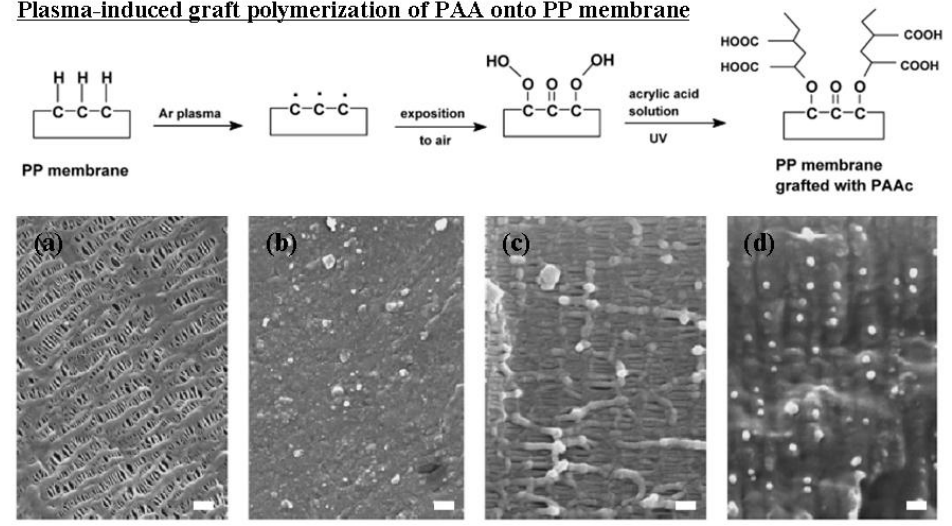
Figure 3. (Top) Schematic drawing of surface modification of microporous PP membranes via plasma-induced graft polymerization of PAA onto PP membrane. (Bottom) SEM images of surfaces [(a) and (b)] and cross-sections [(c) and (d)] of PP [(a) and (c)] and surface-modified PP membrane (b) and (d)] (Scale bar: 1  m). Adapted with permission from Reference [56]. © 2007 Elsevier